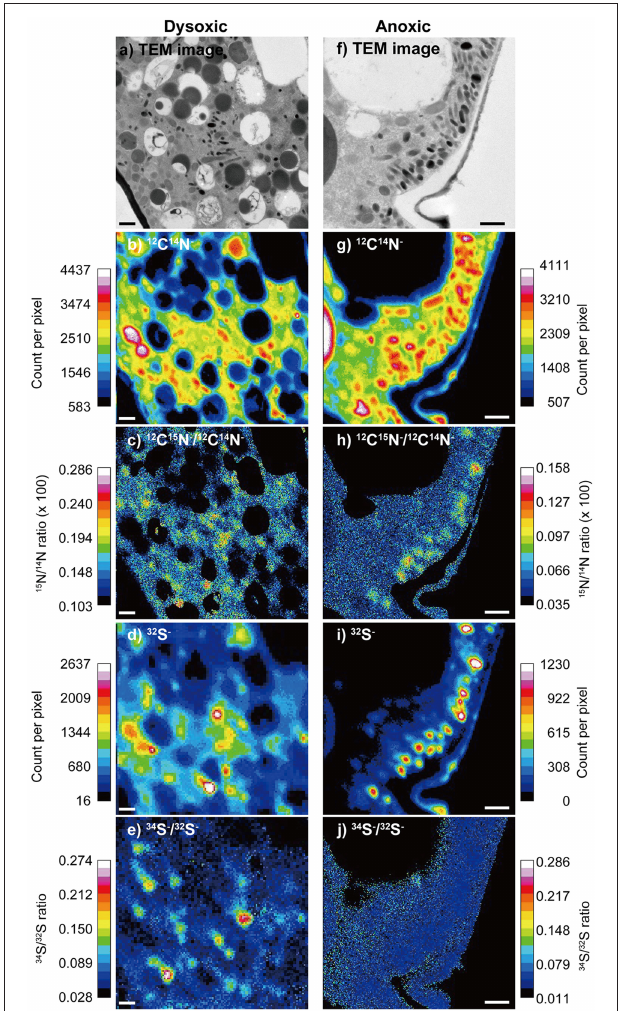
FIGURE 2 | An example of a TEM image and corresponding NanoSIMS images from a dysoxic-incubated (left column) and anoxic incubated (right column) Ammonia sp. specimen. (A,F) TEM image of the measured area ( 12 × 12 µ m for A and 8 × 8 µ m for F ), (B,G) 12 C 14 N − counts, (C,H) 12 C 15 N − / 12 C 14 N − ratio, (D,I) 32 S − counts, and (E,J) 34 S − / 32 S − ratio.